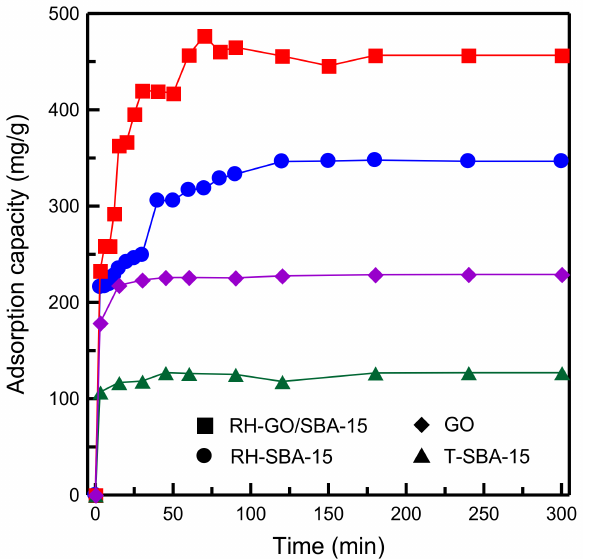
Figure 8. Comparison of adsorption capacity of GO, T-SBA-15, RH-SBA-15, and